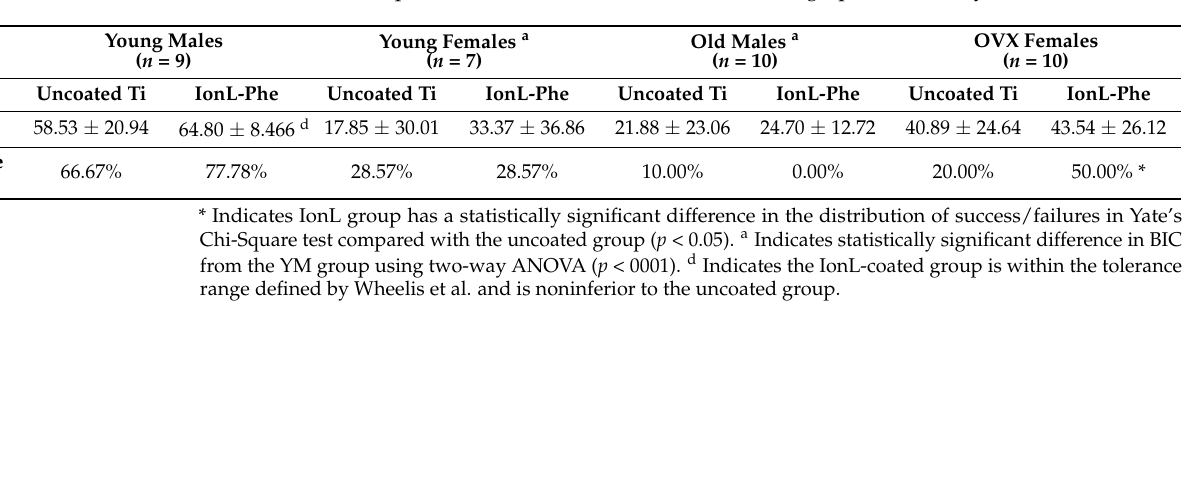
Table 4. Bone-to-implant contact and success rate of all demographics at 30